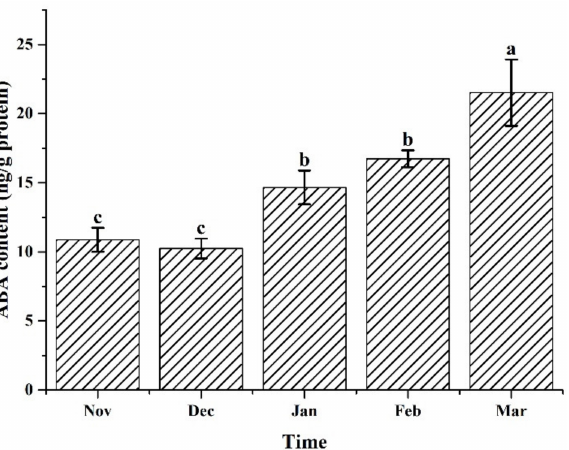
Figure 4. ABA content of N. yezoensis in different samples. Data were Mean ± SD ( n = 3). Different letters indicated significant differences ( p <